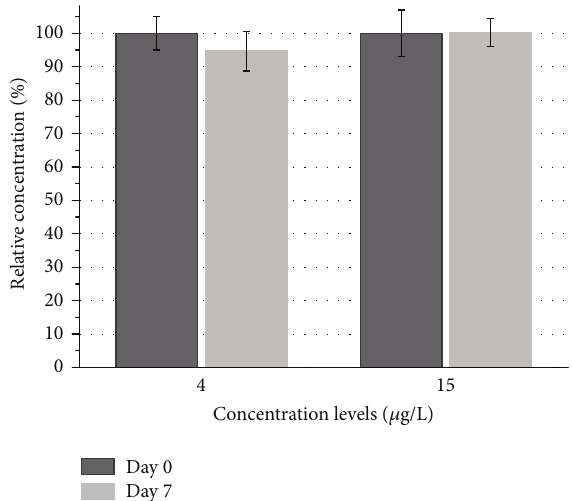
Figure 8: Results of the storage test of end-exhaled air samples over seven days; 𝑛 = 10 per level per day; mean concentration of the start day (Day 0) defined as